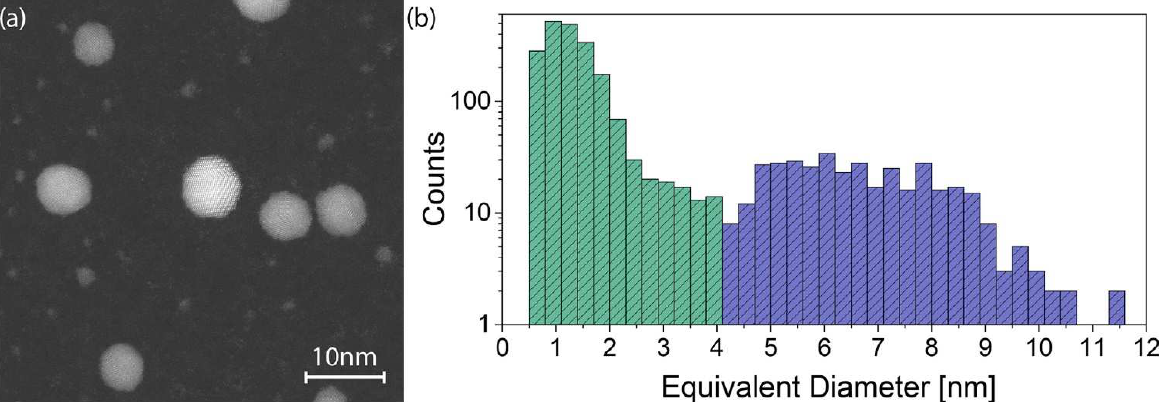
Figure 3. ( a ) HAADF-STEM image of scattered metallic Ag NPs deposited onto a carbon grid. ( b ) Size distribution in log-linear scale obtained from a collection of 100 STEM images of the as-deposited NPs. The distribution has been divided into two colored regions to highlight the partition into small (green) and large (blue) NPs. Reprinted with permission from ref. [25], further permission related to the material excerpted should be directed to the ACS.